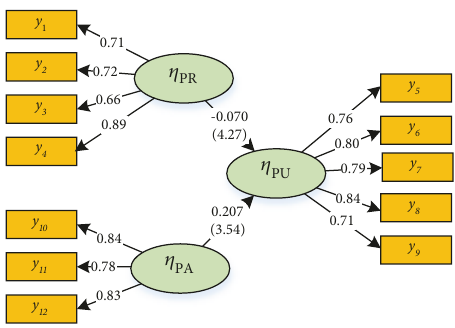
Figure 6: MIMIC submodel for websites.